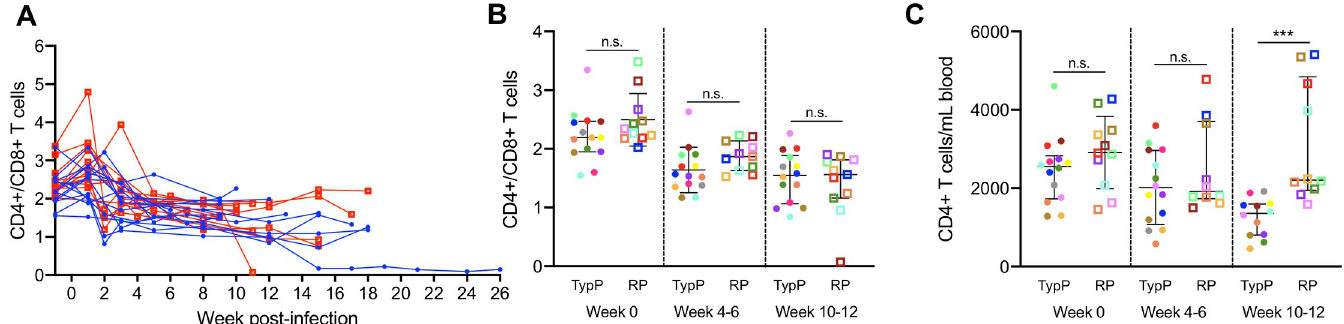
Fig 3. Total CD4 T cell levels are sustained during chronic infection in RP infants. CD4 T cell depletion was monitored over time using a CD4/CD8 ratio in PBMC from TypP ( closed circles, blue lines ) and RP ( open squares, red lines ) infants ( A,B ). The total number of peripheral CD4 T cells was monitored following SIV infection ( C ). Statistical tests used to compare infant groups were carried out as described in the methods � = p < 0.05, �� = p < 0.01, ��� = p < 0.001. Error bars are shown as either mean with standard deviation or median with interquartile range based on data distribution.